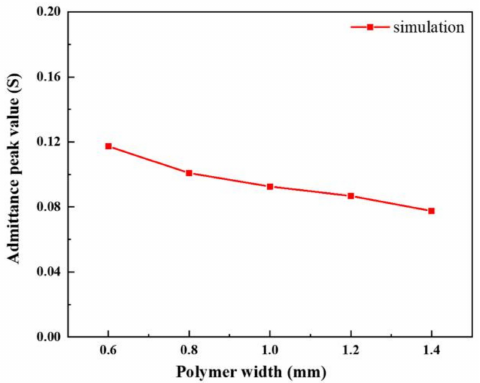
Figure 16. Relationship between transverse polymer width and peak